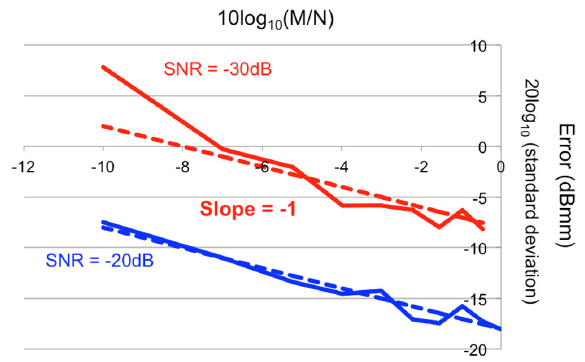
Figure 7. Displacement error in function of M/N for different SNR (simulated data).